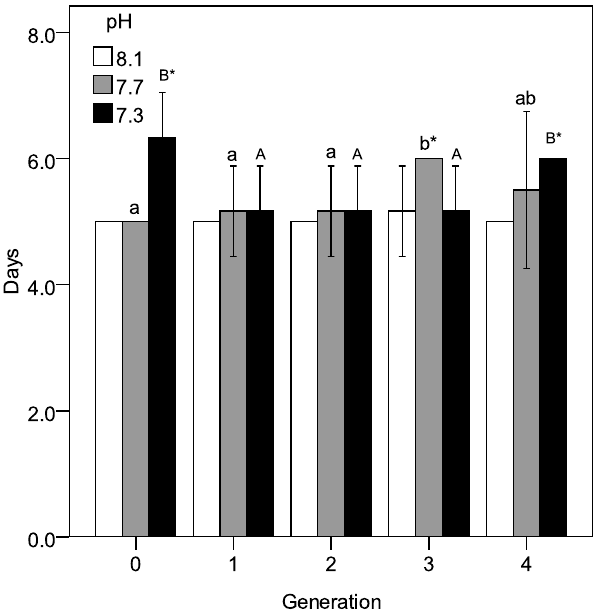
Figure 1. Effect of seawater acidification on naupliar developmental time (mean ± standard deviation, n = 3) of Tigriopus japonicus . All of the five generations were exposed to the same pH levels. Statistical differences among generations ( p < 0.05) are represented by different letters. Asterisks (*) indicate significant differences ( p < 0.05) in the developmental rate between pH 8.1 and pH 7.7, as well as between pH 8.1 and pH 7.3 for each generation.